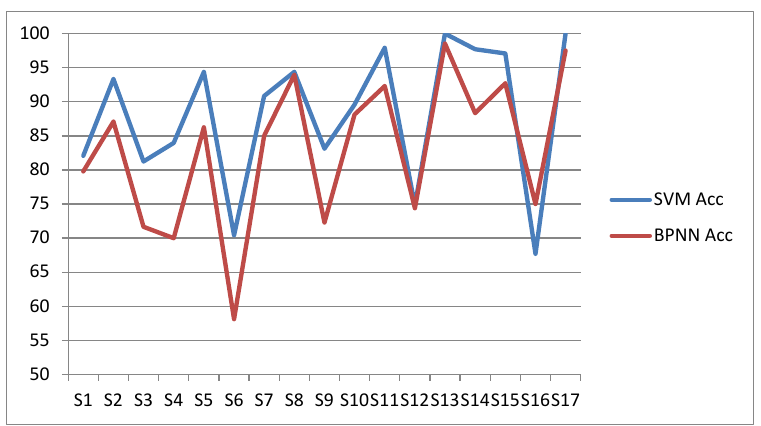
Figure 7. Highest accuracy for each subject with SVM or BPNN classifier. The horizontal axis is the subject index and the vertical axis is